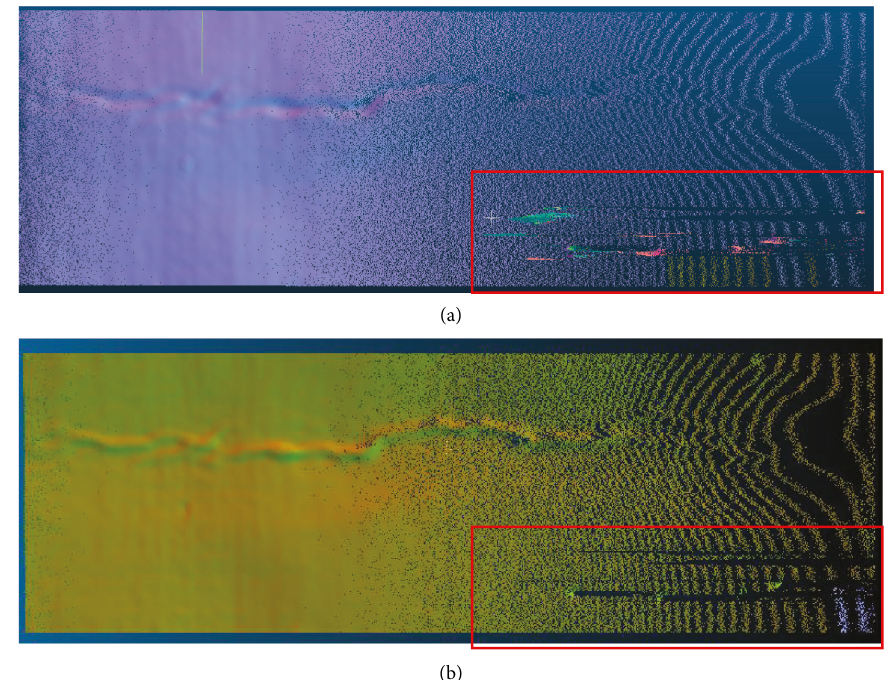
Figure 6: An example of removing noisy point. (a) Origin point cloud with noisy point inside the red rectangle and (b) point cloud after removing noisy points.